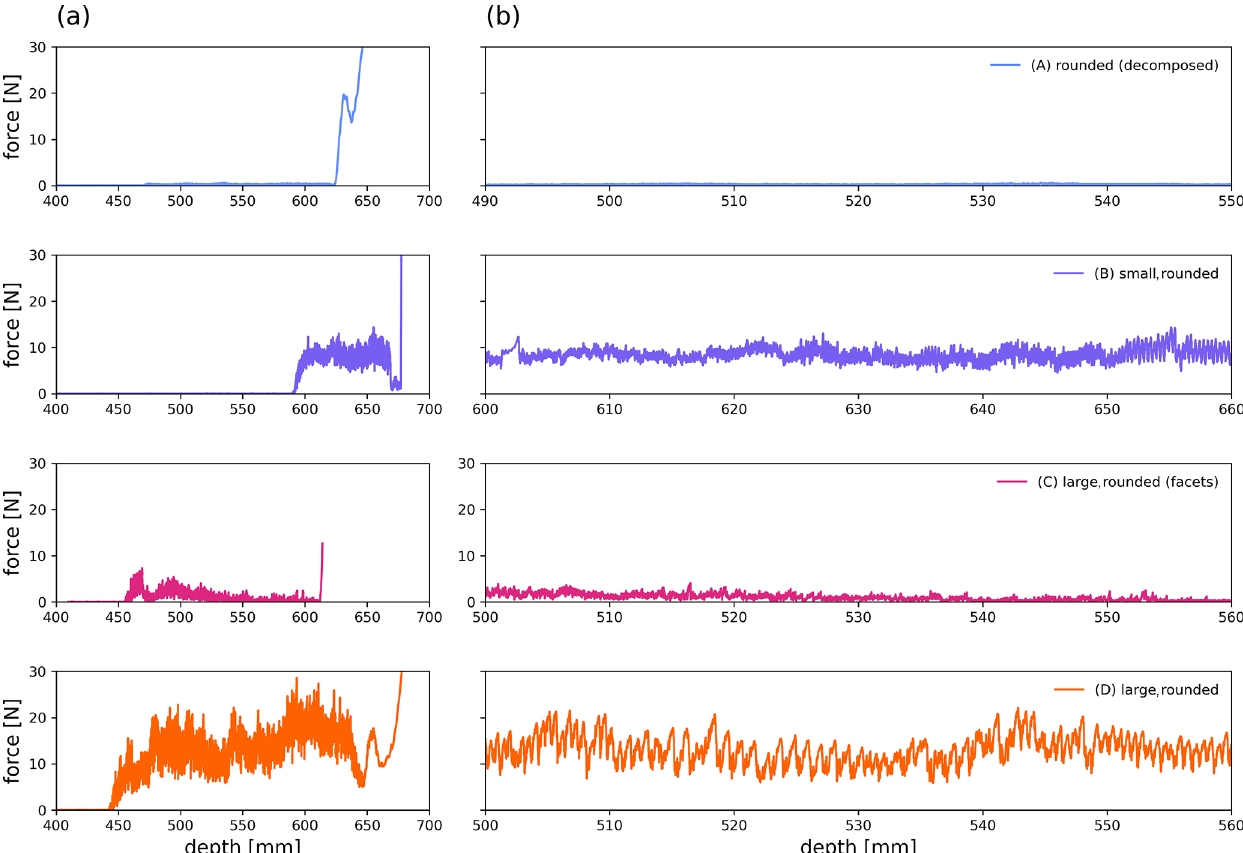
Figure 3. SMP measurements (Schneebeli and Johnson, 1998) for snow types A, B, C and D. Snow type E was unsuitable for SMP mea- surements due to its fragility and heterogeneity. Panel (a) shows the force profile, in newtons, for the whole snow block. Panel (b) displays the homogeneous layer (approximately 6cm within the snow block) that we used for our sampling procedure.